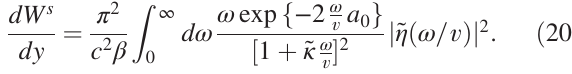
FIG. 5. Relative position of “ snapshots ” area, bunch, and wires for surface wave field distributions in Fig. 4. The area with calculated distributions is shown as a solid blue horizontal line on the left projection and as a square with a dashed blue border on the right projection. The bold arrow shows the direction of the bunch